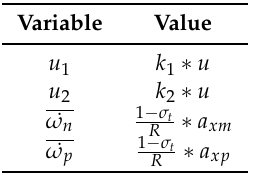
Table 1. ABS threshold definition.